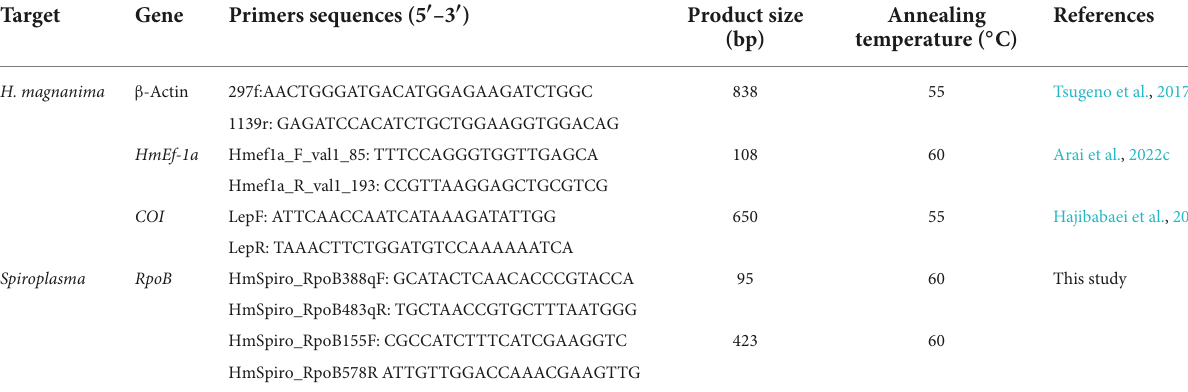
TABLE 1 Sequences and related information of the primers used in this